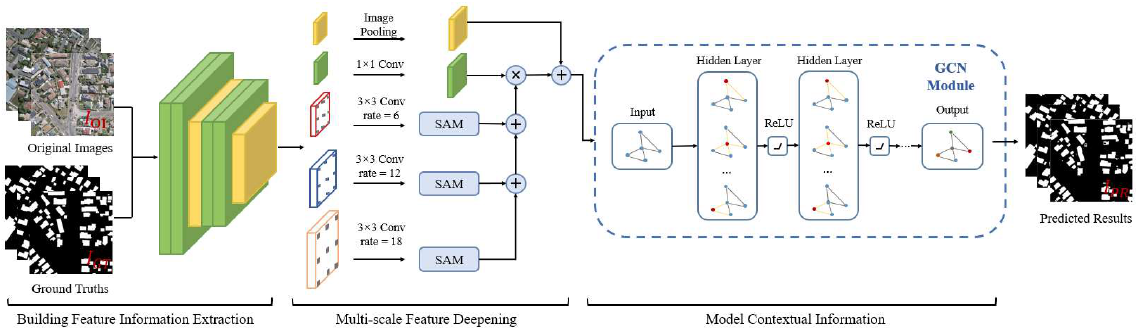
Figure 1. The structure of our proposed BGC-Net, consisting of three parts: FE module, AAP module, DGC module.